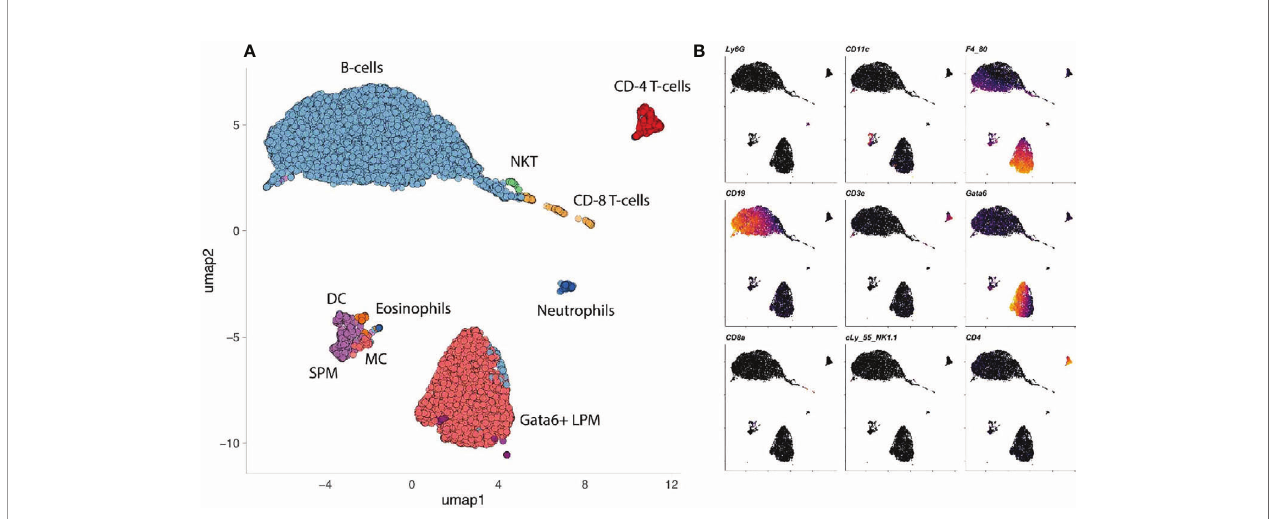
FIGURE 3 | Cells in a mouse coelomic cavity. (A, B) Peritoneal cavity lavage of healthy C57Bl/6 mice. Dimensionality reduction dimension 1 (umap1) and 2 (umap2) of myeloid lineage markers (mass cytometry) are plotted on x- and y-axis, respectively. Dots (cells) are colored by cluster (A) or marker (B) . Data with kindly permission from M. Dosch and G.